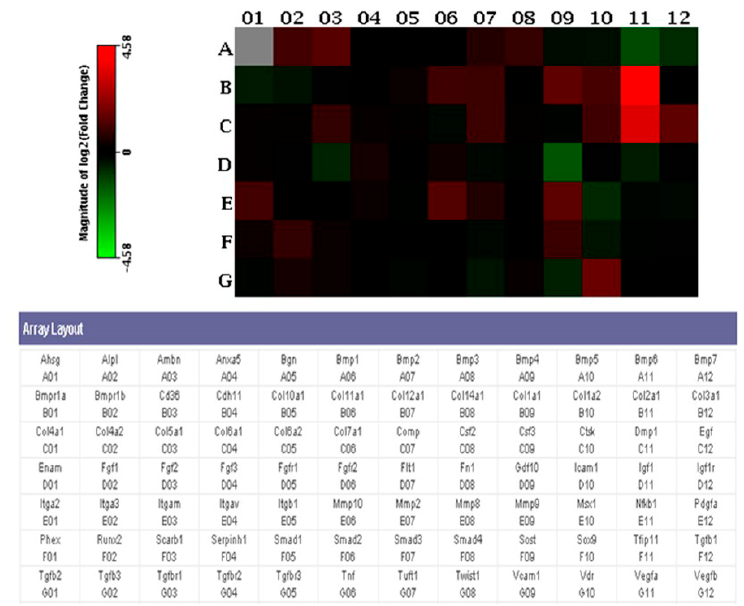
Figure 6. Rt 2 Profiler Osteogenesis PCR Array. Array layout was presented, and the heat map represented the expression level of 84 genes. The red squares represented genes expressed higher in the CO group, and the green squares represented genes expressed higher in the BMSC group. Table 1. Differentiated gene list between the CO and BMSC groups (fold changes > 2) is shown in the table.